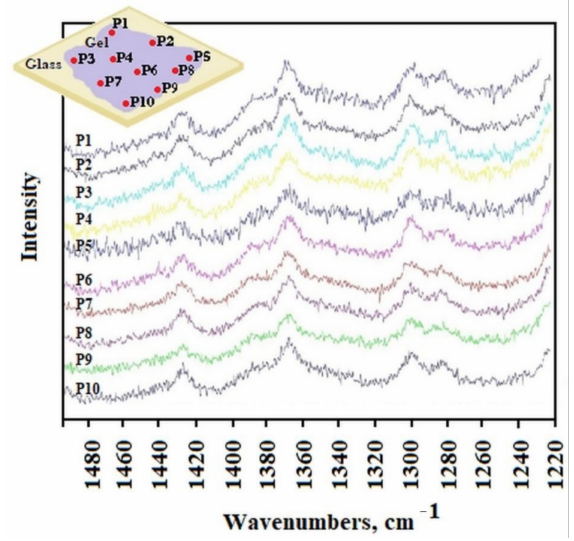
Figure 4. Raman spectra as a function of position on the surface (from P1 to P10) of the C 12 ALA- AuNP sample.